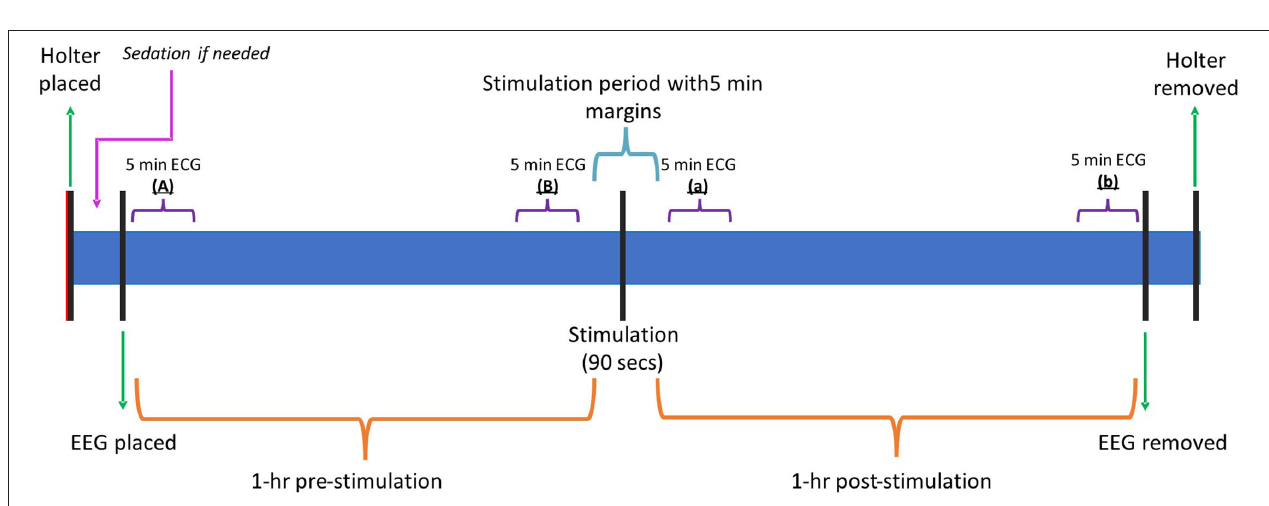
FIGURE 4 | Timeline graphic summarizing the different events and key points during the recording. Min, minutes; Hr, hour; ECG, electrocardiogram; EEG, electroencephalogram.